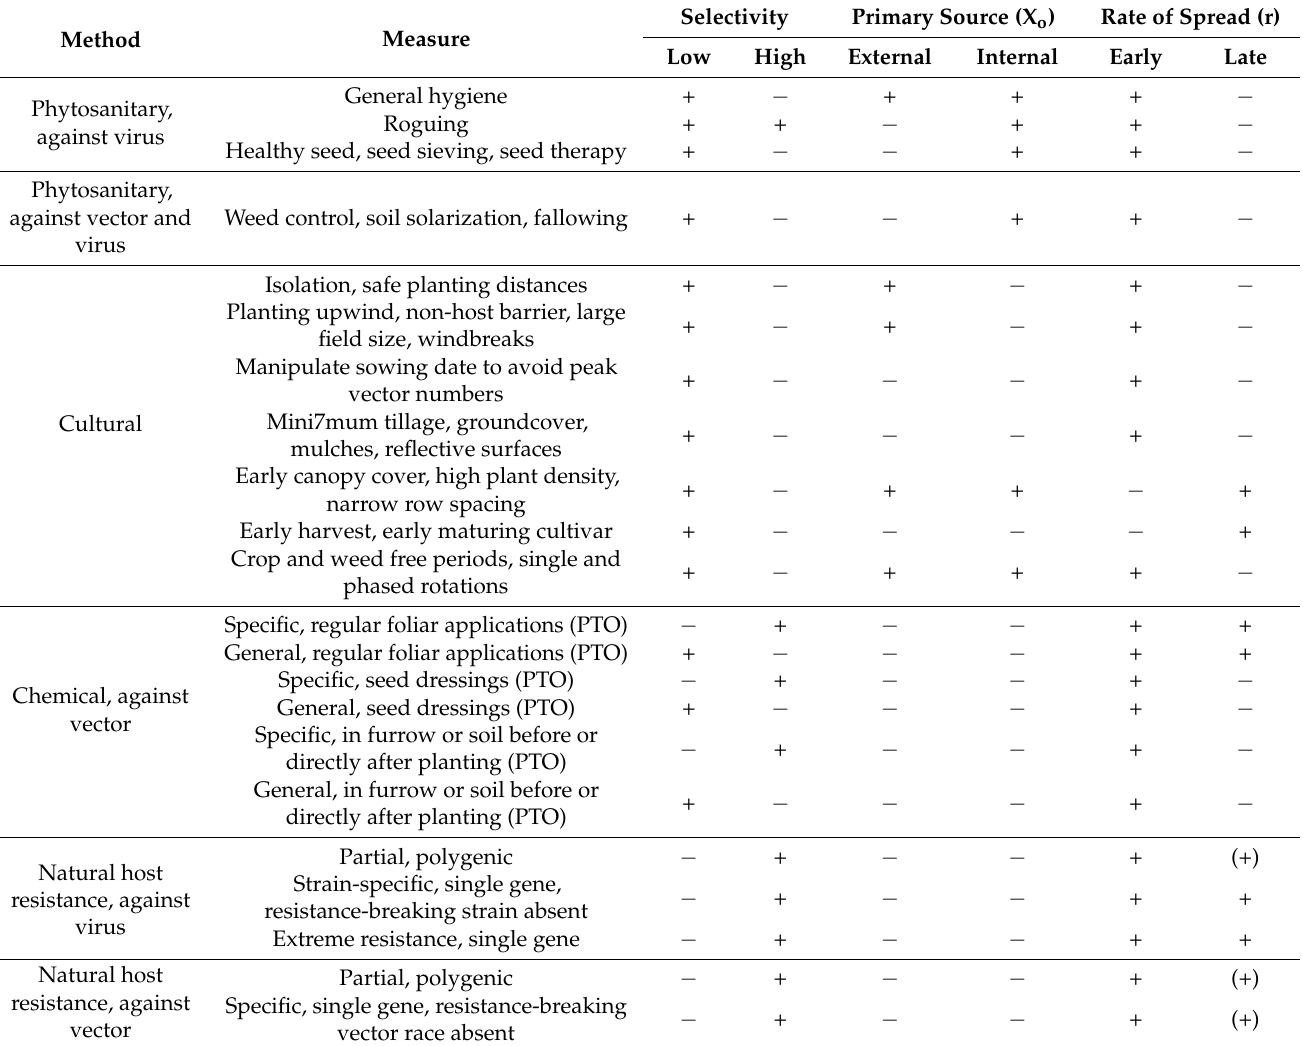
Table 1. The selectivity and activity against primary virus source(s) and virus spread exhibited by different control measures. Method Measure